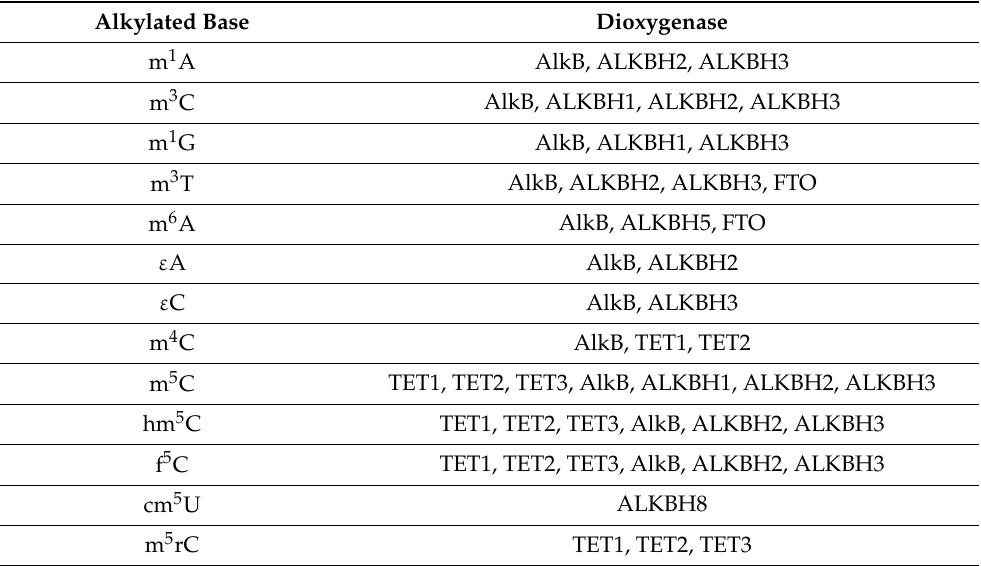
Table 1. A summary of 2-ketoglutarate-dependent DNA dioxygenases and their alkylated DNA and RNA